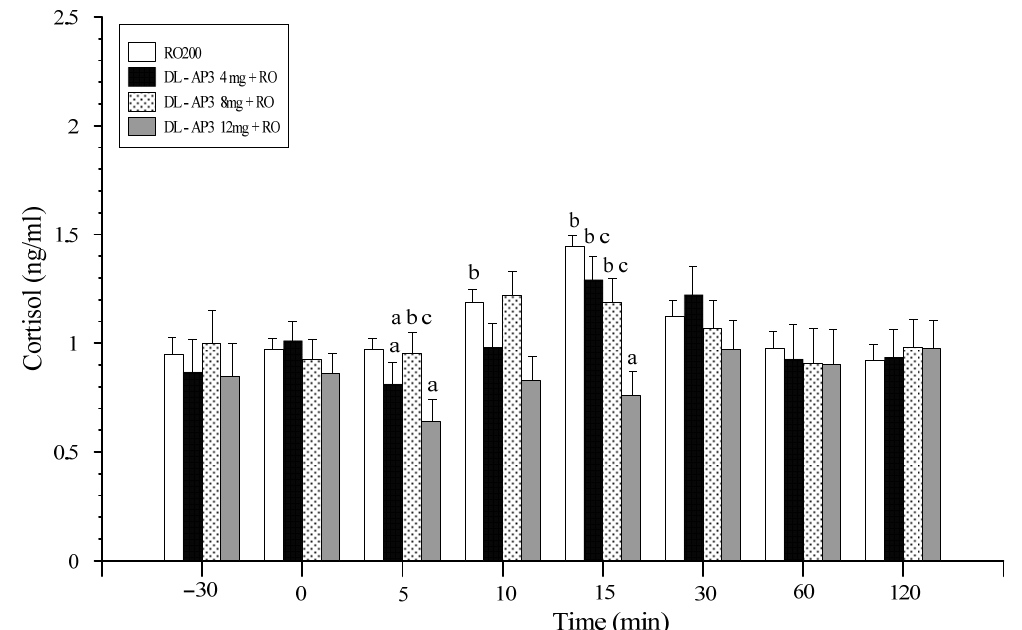
Figure 13. Summed from three doses, mean changes in plasma cortisol levels (ng·mL − 1 ) in the test groups of animals. Control group (200 µL of 0.9% NaCl), RO200, and after ICV infusion 10 min premedication with three different doses of L-AP 3 (0.2, 0.4, and/or 0.8 mg in toto) and DL-AP3 (2, 4, and/or 8 mg in toto) in the RO200 test within 120 min of completing the RO procedure (mean ± SD, n = 6) [34]. Key: a—significant differences ( p ≤ 0.05) compared with the value of 0.9% NaCl; b—significant differences ( p ≤ 0.05) compared with the value of the RO200 group; c—significant differences ( p ≤ 0.05) between the L-AP 3 and DL-AP 3 groups .